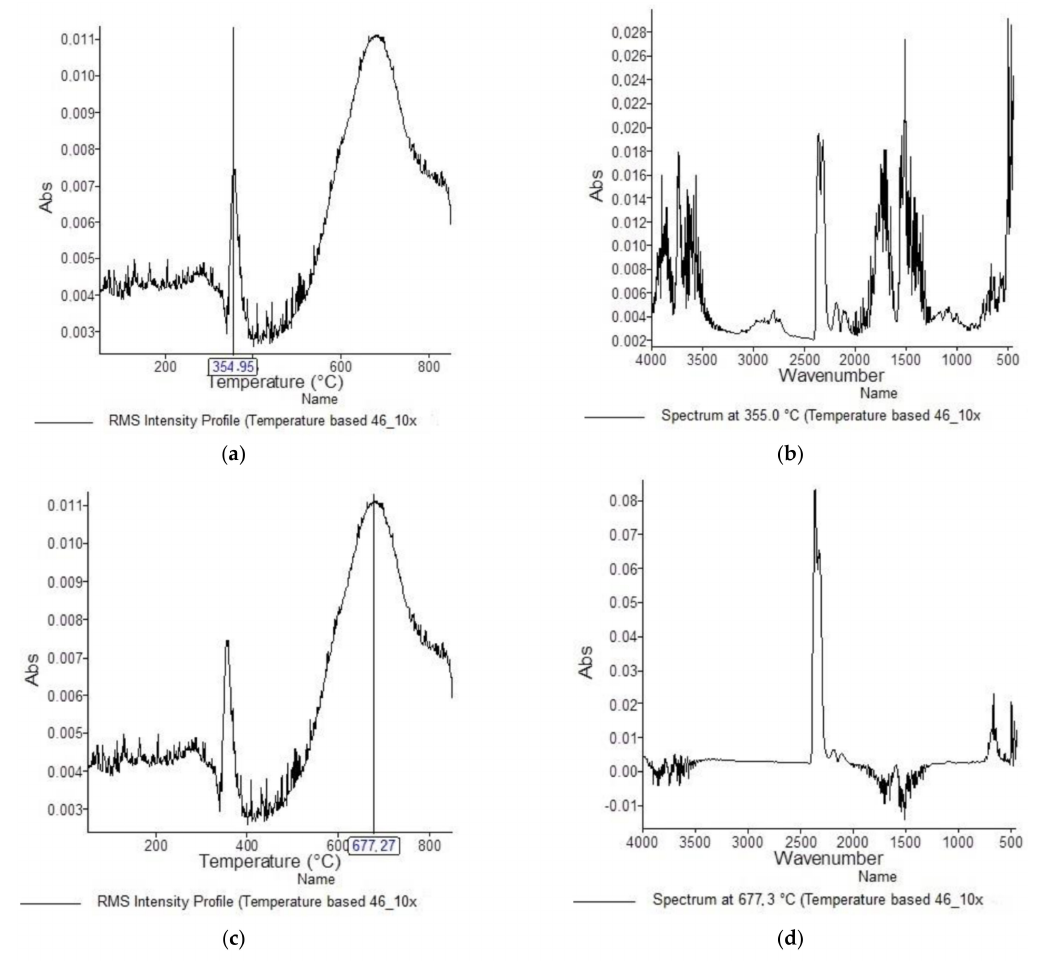
Figure 4. TG–IR analysis of 46_10x during thermo–oxidative decomposition: ( a ) and ( c ) intensity profile FT–IR spectrum of gas evolved, ( b ) FT–IR spectrum of gas evolved at 355.0 ◦ C, ( d ) FT–IR spectrum of gas evolved at 677.3 ◦ C.